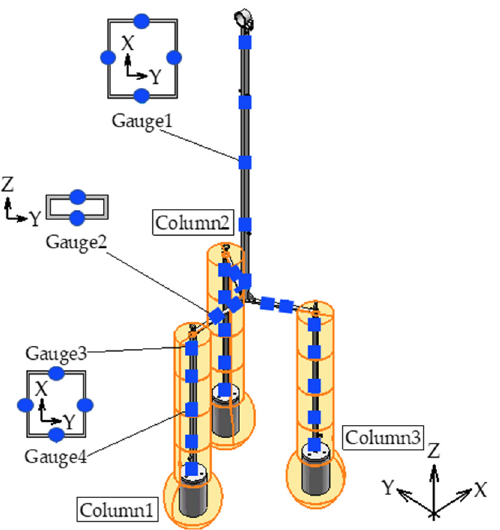
Figure 5. Location of the strain gauges on the experimental model.